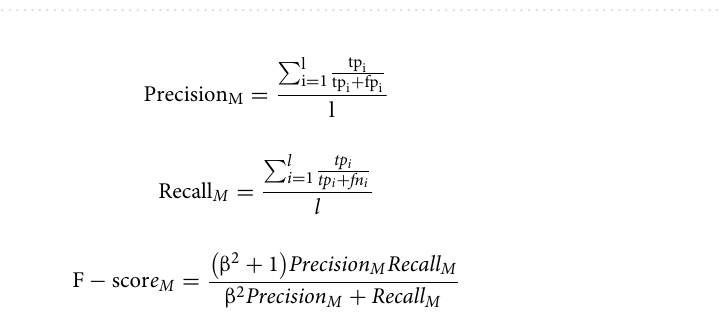
Figure 7. Demonstration of the consecutive process of CAM aggregation. The black background and red- bordered squares in ( a ) indicate the zero-padded pixels and sliding windows, respectively. The patched heatmaps in ( b ) represent the CAM outputs of the corresponding window, calculated from the last activation layer of each model. ( c ) Aggregated and averaged CAM outputs over the entire bark. ( d ) Superimposed image of the heatmap to the original